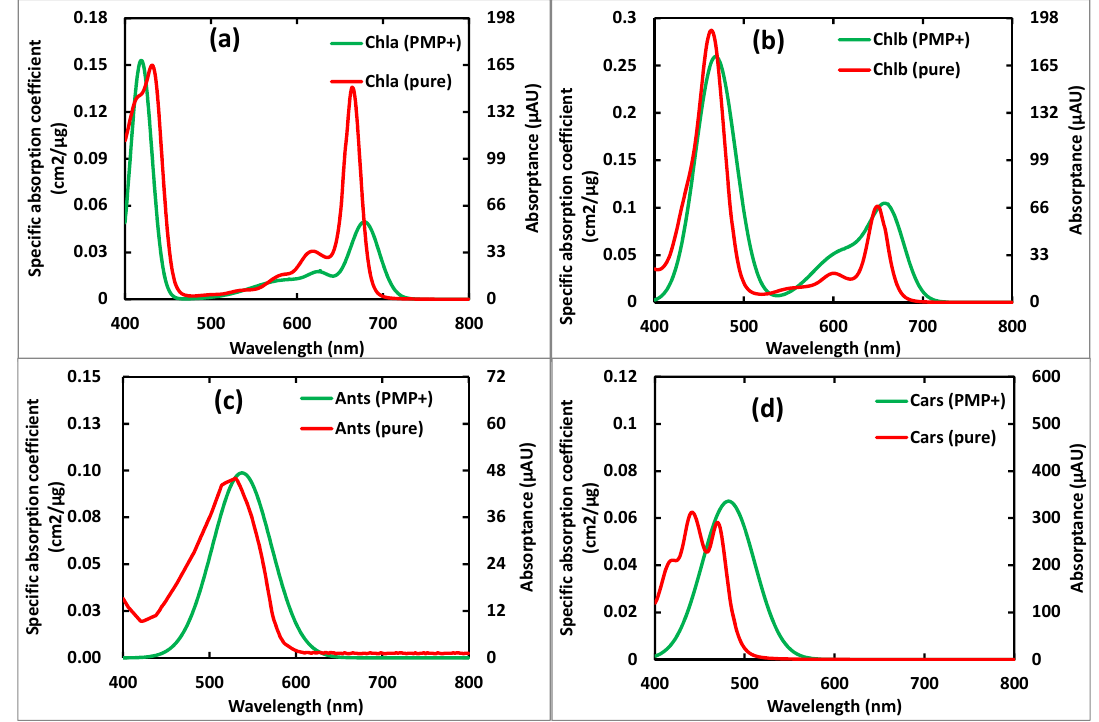
Figure 3. Optical property comparison of the determined pigment absorption coefficients in vivo leaf from PROSPECT-MP + (PMP + ) and the absorption spectra of the pure pigments in the organic solution from pure pigments: ( a ) Chla; ( b ) Chlb; ( c ); and( d ) Ants.